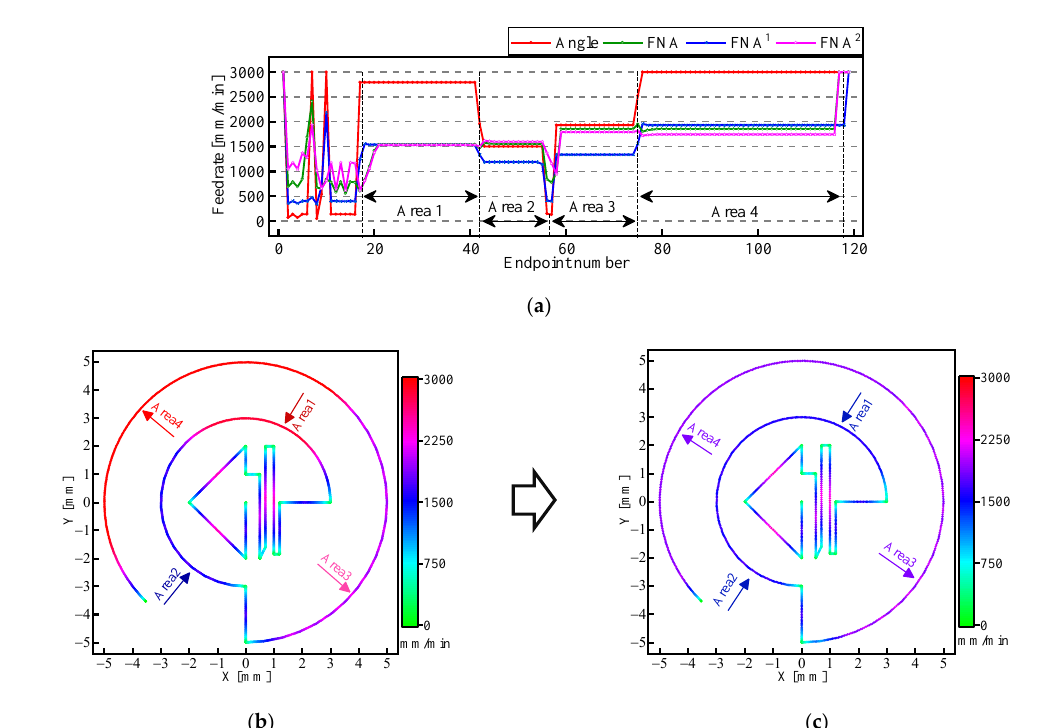
Figure 7. The feedrate planning results of the 2D machining path: ( a ) the feedrate-constraint value obtained from different methods (FNA 1 : The FNA method without the trajectory prediction. FNA 2 : The FNA method without the acceleration filtering); ( b ) the feedrate planning result of the angle-constraint method; ( c ) the feedrate planning result of the FNA method.